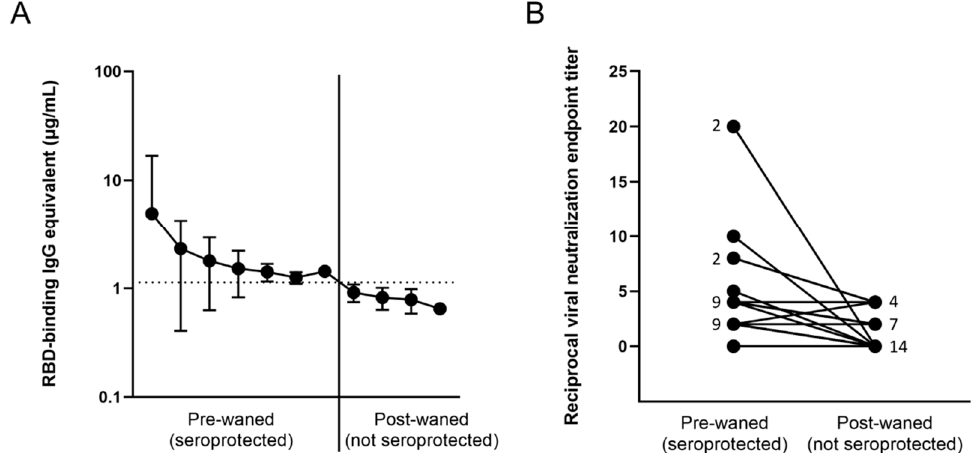
Figure 4. Loss of antibody-protected status based on ( A ) antibody binding, and ( B ) viral neutralization in waned participants. ( A ) All 25 participants demonstrated a loss of anti-RBD binding antibodies; ( B ) only 13 showed a loss of neutralization potential, signified by an initial non-0 neutralization endpoint titer and an endpoint titer of 0 at the post-waned timepoint. The numbers next to the dots represent the number of overlapping participants with the same neutralizing endpoint